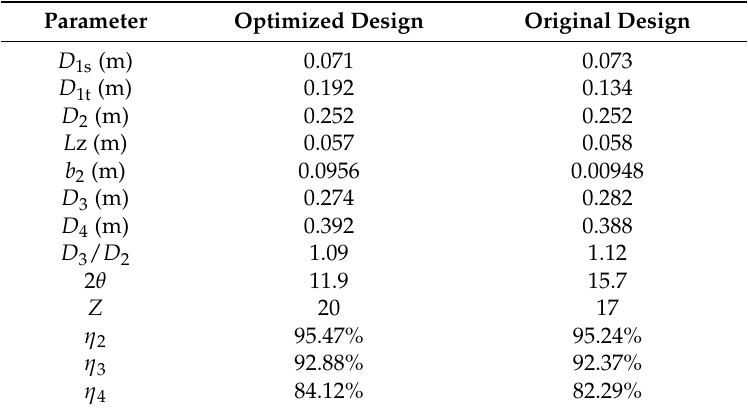
Table 3. Comparison of the parameters of the optimized and original designs.